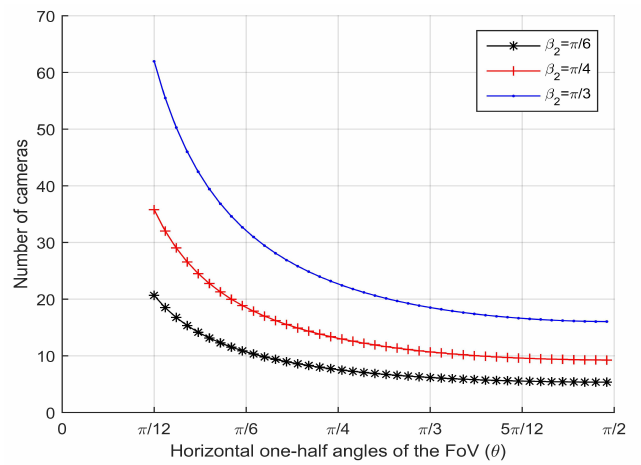
Figure 7. Number of camera sensors per 100 m vs. horizontal one-half angle of field of view (FoV) for different maximum effective vertical angles.